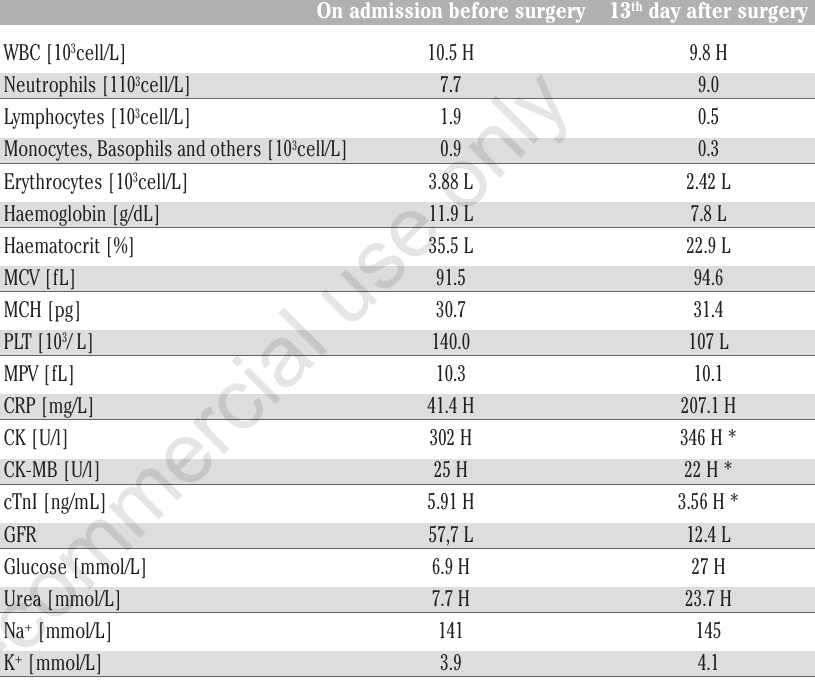
Table 1. Pre- and postoperative biochemical parameters of a surgical patient for atrial myxoma and coronary artery stenosis. On admission before surgery 13 th day after